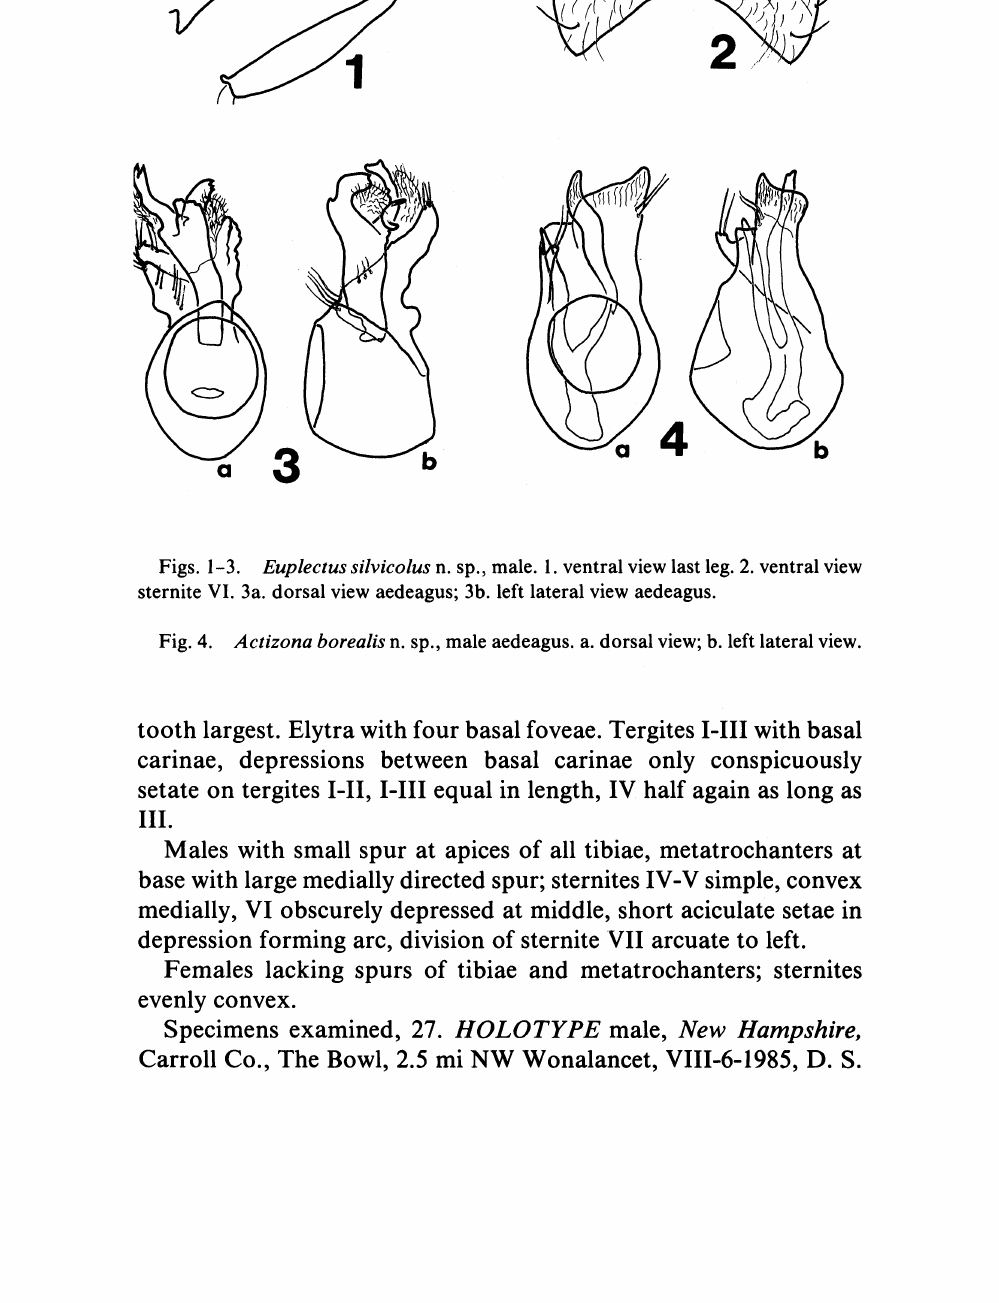
Figs. 1-3. Euplectus silvicolus n. sp., male. 1. ventral view last leg. 2. ventral view